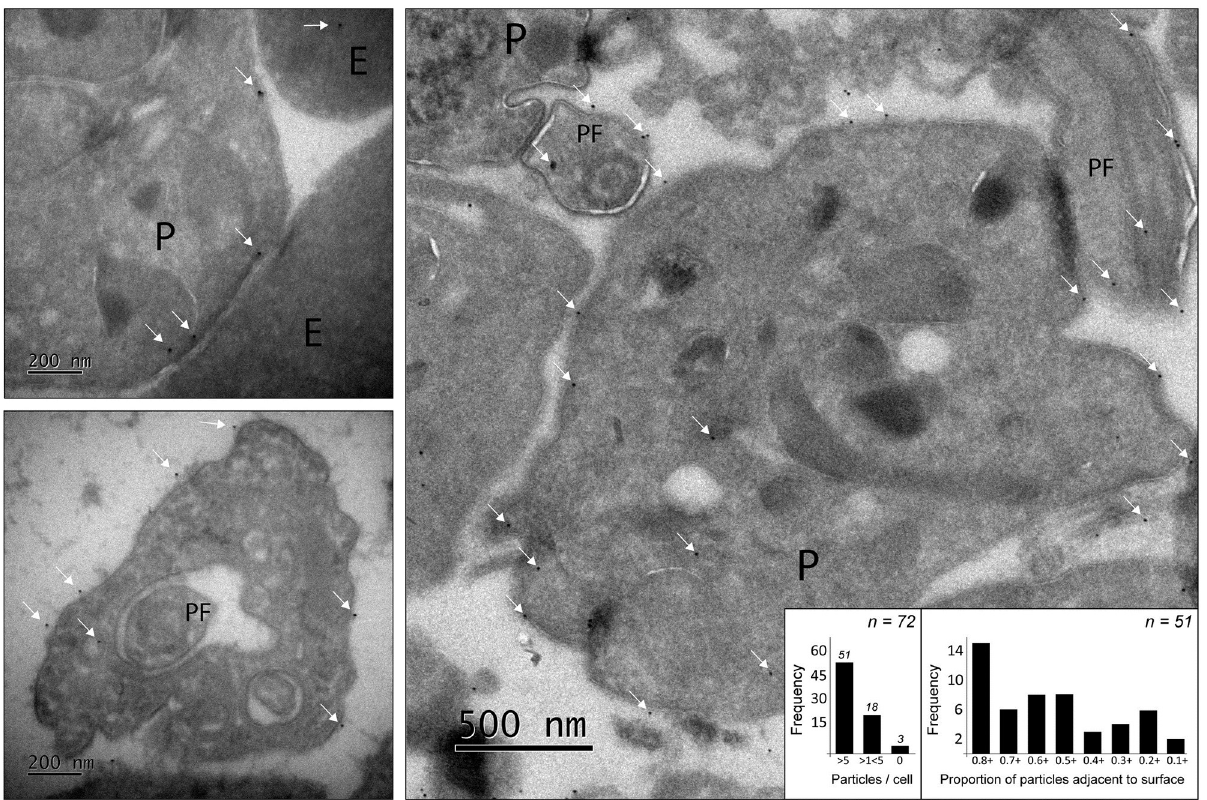
Fig 6. Localisation of VIV β 8 by immunolabelled transmission electron microscopy. Parasites (P) and erythrocytes (E) derived from murine infections were labelled with anti-VIV β 8 polyclonal antibodies. VIV β 8 was localised to the whole parasite cell surface (top and bottom left), and to the parasite flagellum (PF). Anti-VIV β 8-coated gold particles are indicated by white arrows. The right-hand image shows the predominant localisation of VIV β 8 to the surface, although intracellular positions are observed. The graph (inset) shows the proportion of labelled cells and a frequency distribution of the proportion of anti-VIV β 8-coated gold particles found adjacent to the parasite cell membrane of labelled cells.